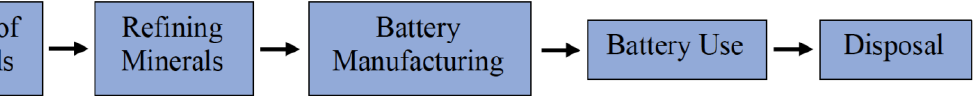
Figure 1. Current linear economy for lithium-ion electric vehicle batteries.